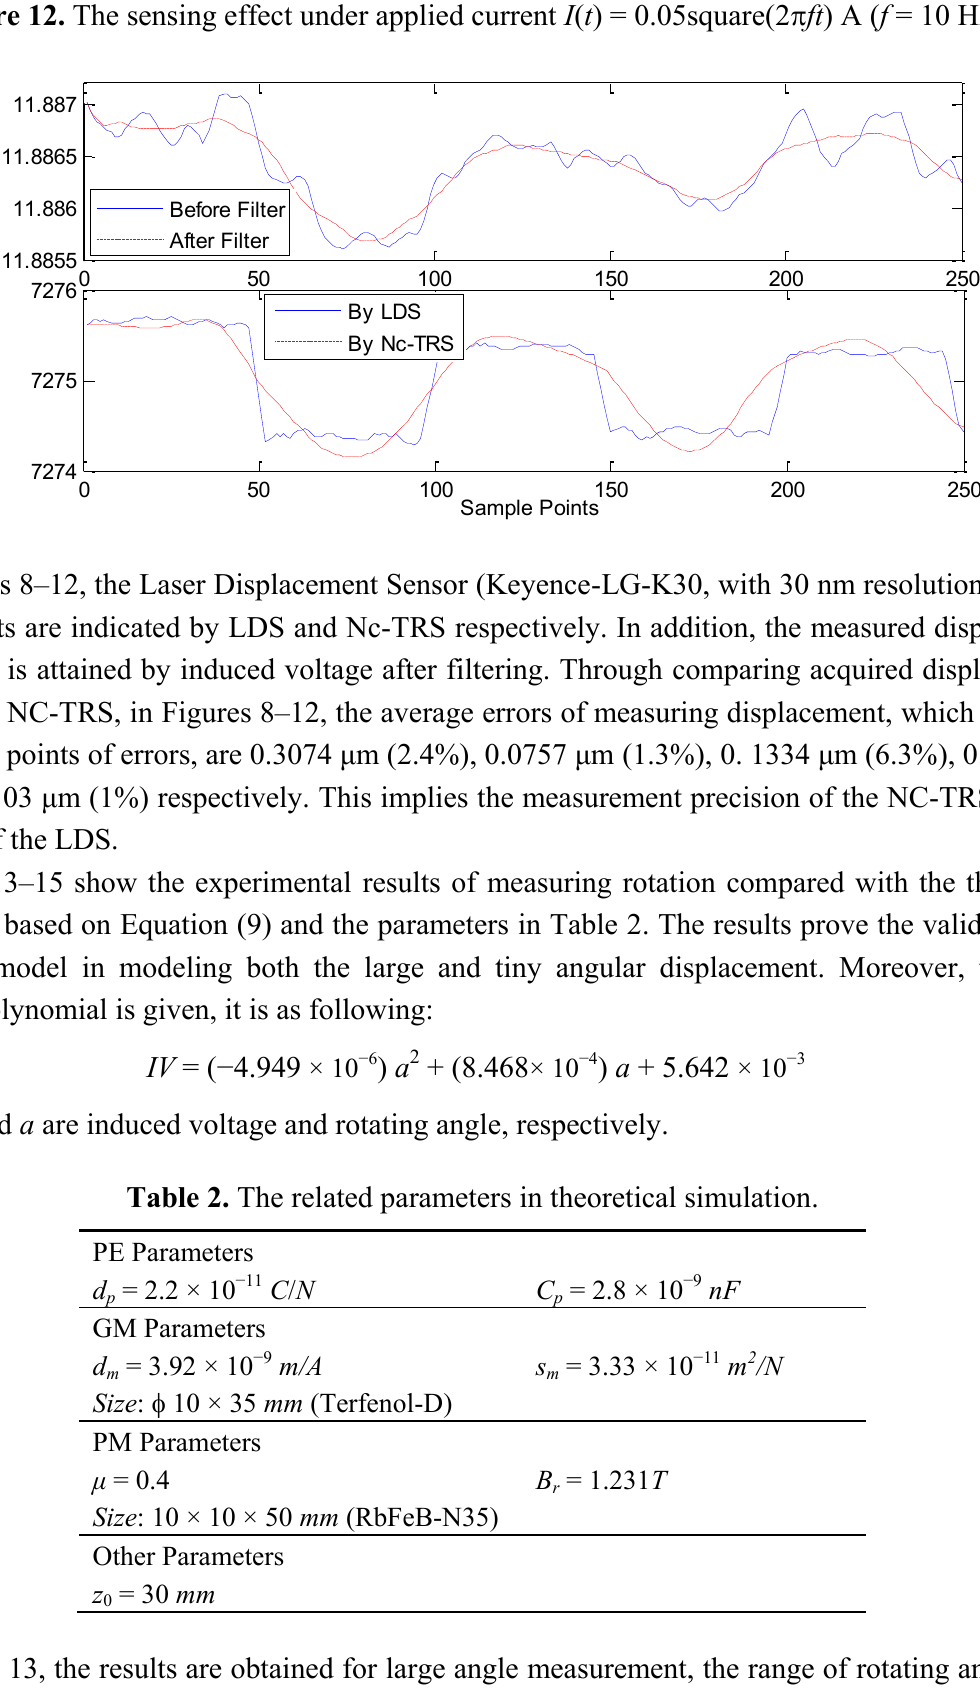
Figure 12. The sensing effect under applied current I ( t ) = 0.05square(2  ft ) A ( f = 10 Hz).